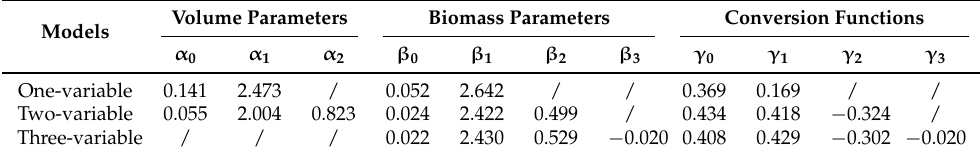
Table 3. Parameters for compatible tree volume and aboveground biomass equations.